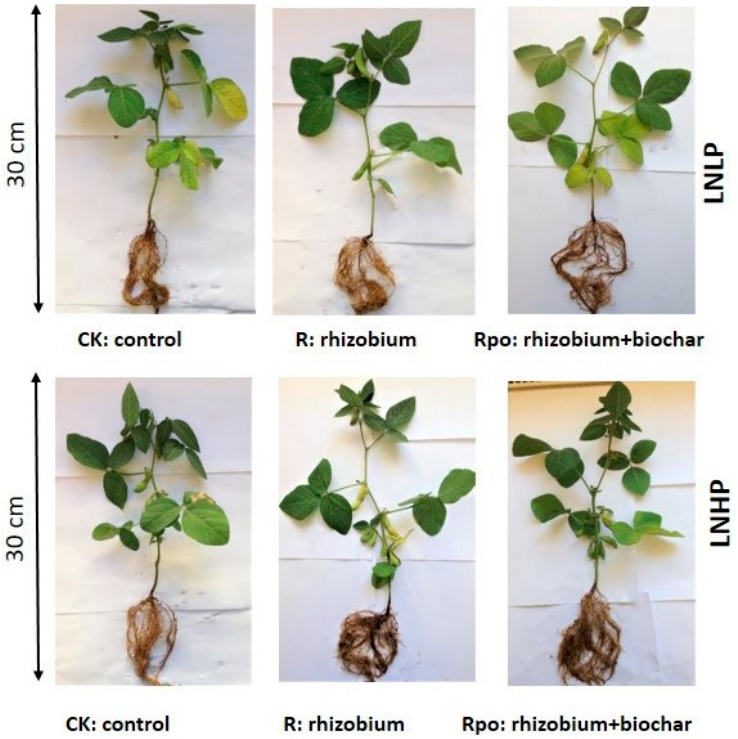
Figure 1. The root and shoot growth of soybean plants after exclusive rhizobium inoculation and rhizobium inoculation combined with biochar application under low N or low and P supply. LNLP, low N and low P; LNHP, low N and high P; CK, control; R, Rhizobium inoculation; Rpo, Rhizobium inoculation with biochar application.